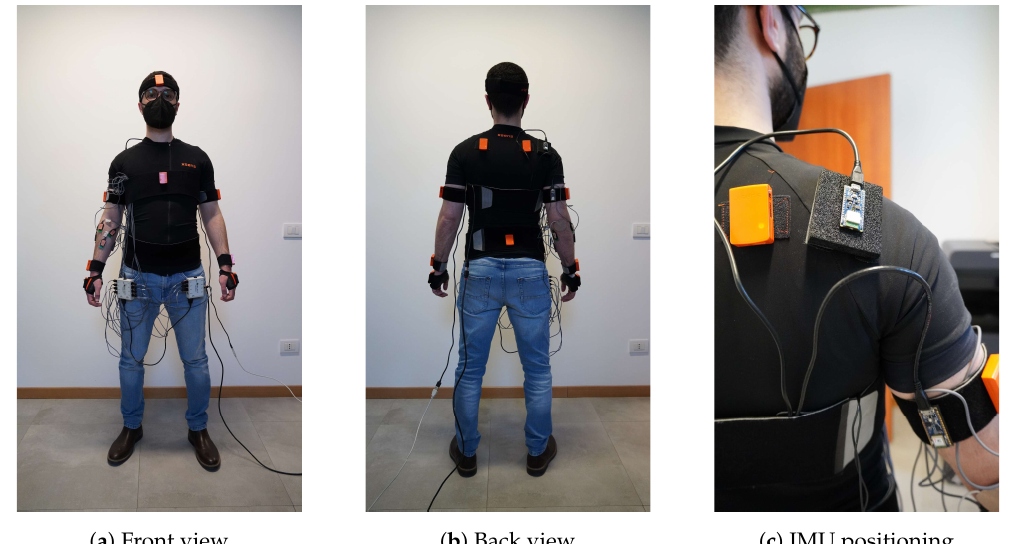
Figure 4. Different views of the complete sensor setup (including the ground truth sensors) used during the experimental phase. The full-body view of the system — composed by the Delsys Bagnoli EMG system (Delsys Inc., Natick, MA, USA), the Xsens MTw Awinda (Movella Inc., Henderson, NV, USA) wearable system and the two LSM9DS1 inertial sensors embedded in Arduino Nano 33 BLE boards (Arduino S.r.l., Monza, Italy) — is shown in ( a , b ). A detail of the IMUs positioning is depicted in ( c